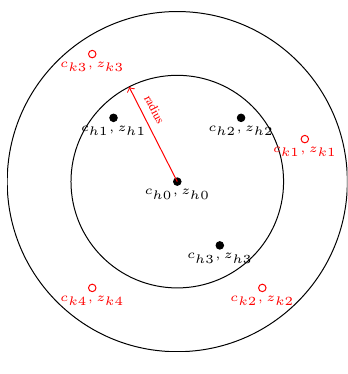
Fig. 7. Agent neighborhood. Fig. 10. Average degree for different values of s